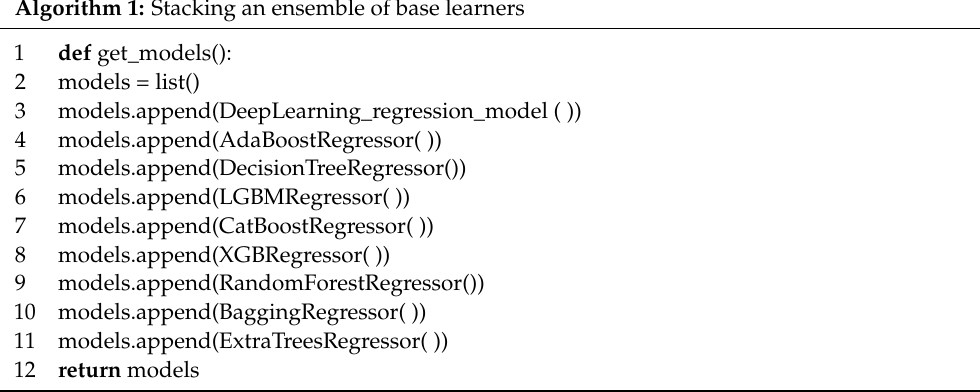
Algorithm 1 is about model architecture creating a stack of ensemble models as base learners for the Super Learner. Modified after [56]. Algorithm 1: Stacking an ensemble of base learners